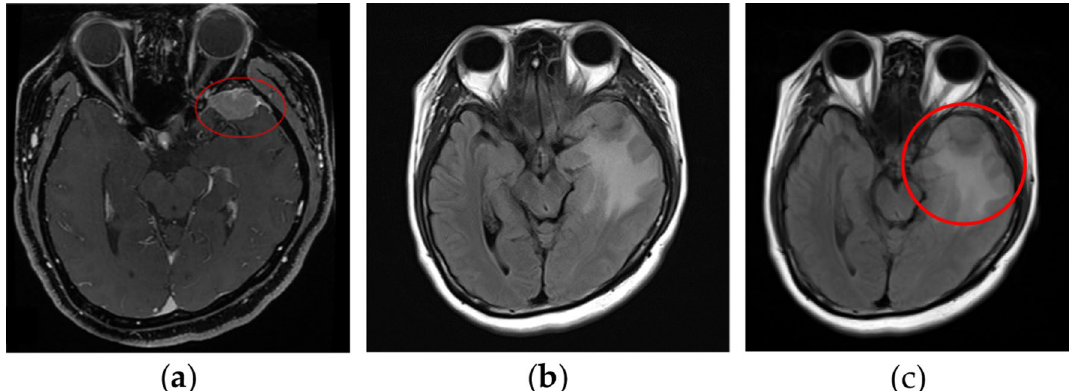
Figure 2. MRI images before treatment and MRI images after image fusion. ( a ) MRI before treatment. ( b ) MRI 4 months after treatment. ( c ) Cerebral edema area with fusion technology. MRI magnetic resonance